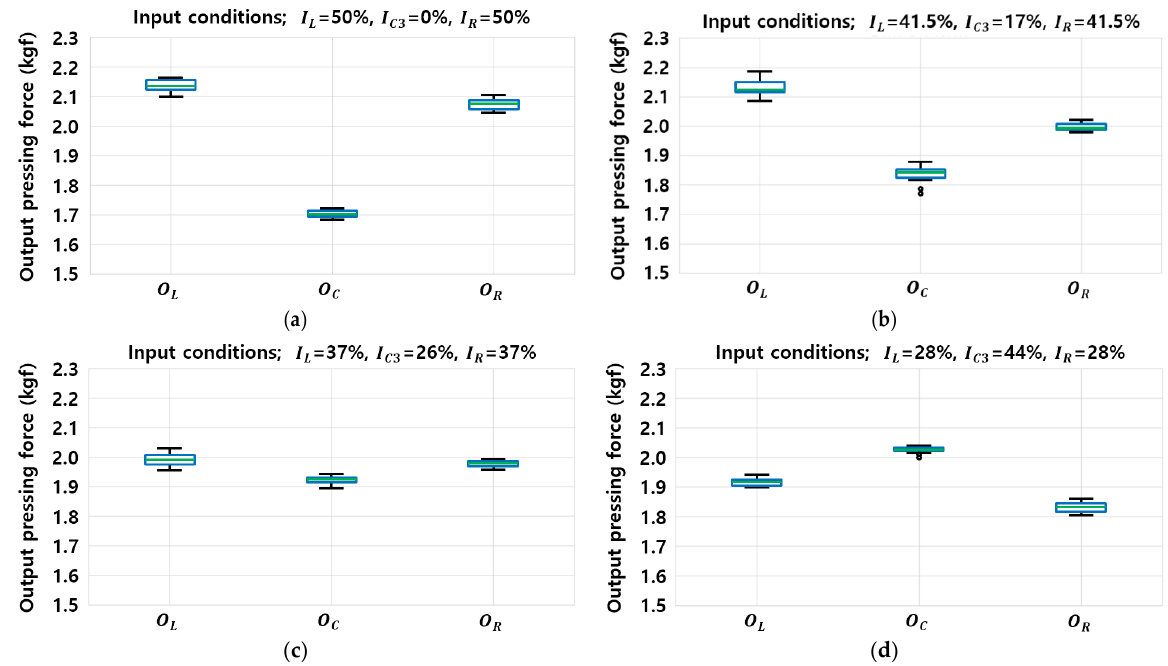
Figure 10. Experimental results for regression analysis; output pressing force from left ( O L ), central ( O C ) and right ( O R ) sections of roller for the inputs: ( a ) Left force 200 kgf, right force 200 kgf; ( b ) Left force 165 kgf, right force 165 kgf and center force 70 kgf; ( c ) Left force 148 kgf, right force 148 kgf and center force 104 kgf; ( d ) Left force 112 kgf, right force 112 kgf and center force 176 kgf. Table 2. Optimized load value of Figure 11b.